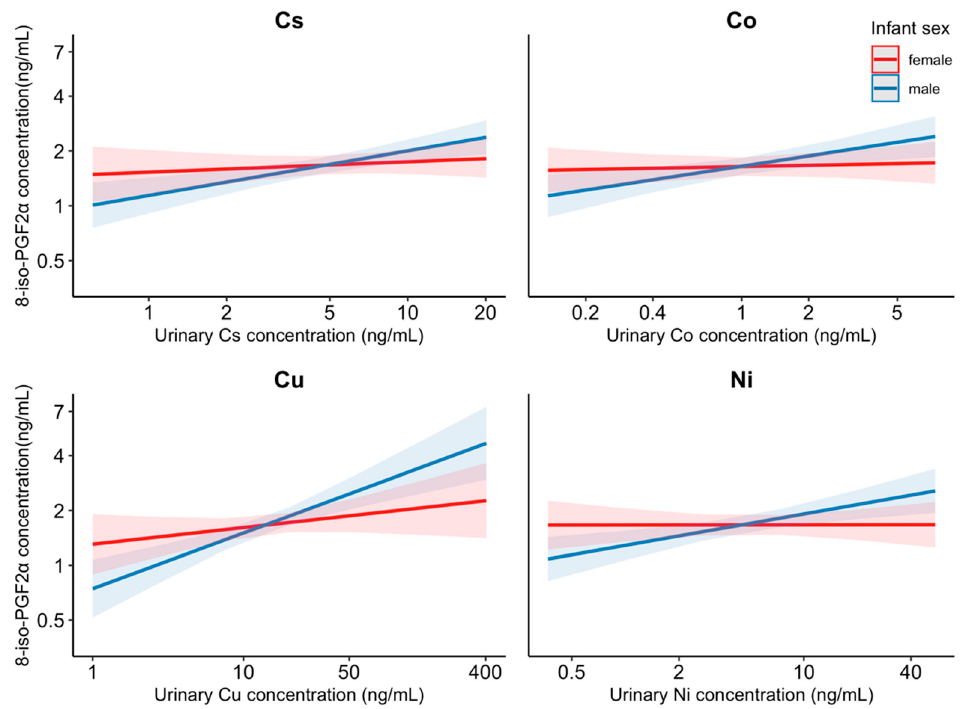
Figure 4. Interaction effect of infant sex on the association between the urinary Cs, Co, Cu, and Ni concentration and 8-iso-PGF2 α . Models were adjusted for specific gravity, study visit, maternal age, maternal education, marital status, pre-pregnancy BMI, and exposure to secondhand smoking. Abbreviations: cobalt (Co); cesium (Cs); copper (Cu); nickel (Ni). Lines indicate dose-response curve and shading indicates 95% confidence intervals.